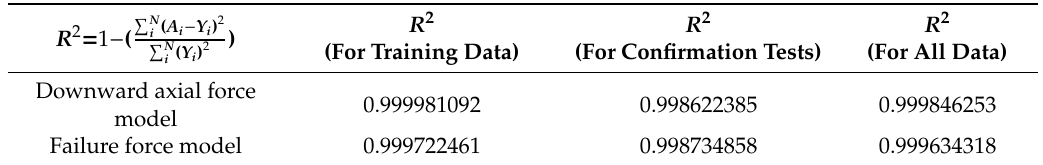
Table 7. The amount of correlation coe ffi cient ( R 2 ) for the training data, confirmation data and overall data for the developed ANN models.